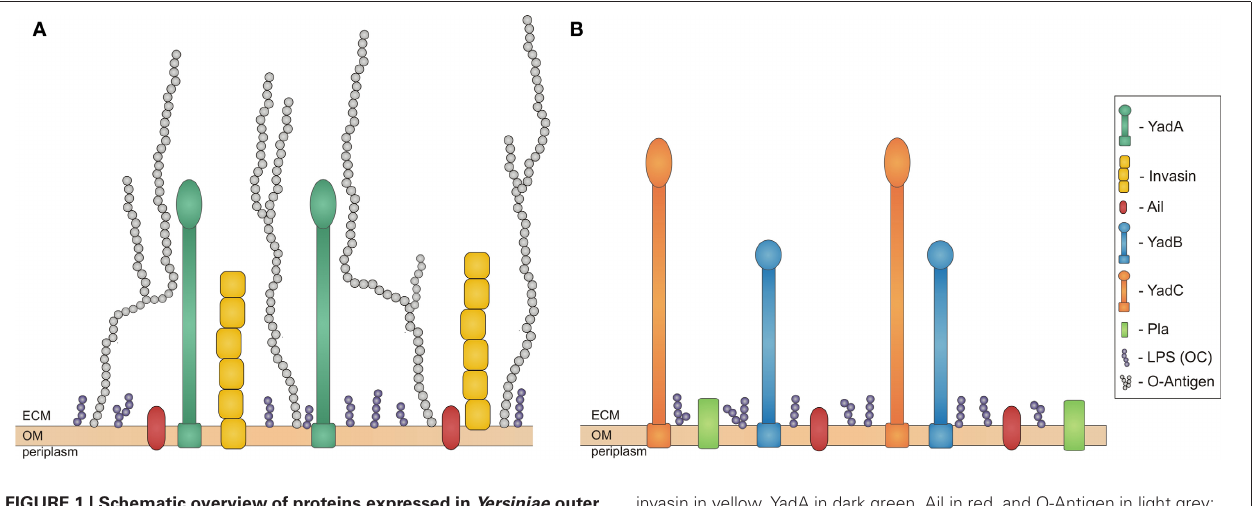
invasin in yellow, YadA in dark green, Ail in red, and O-Antigen in light grey; (B) Adhesins of Y. pestis : Pla in green, YadB in blue, YadC in orange, Ail in red. ECM stands for extracellular matrix. All the molecules are on approximately the same